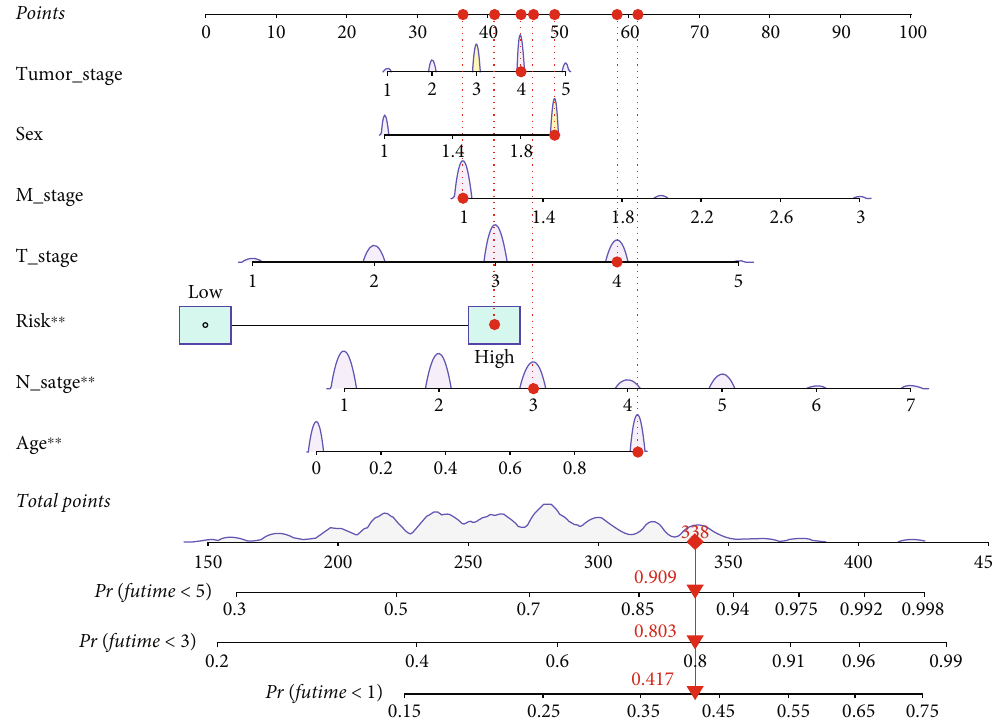
Figure 6: The nomogram of traditional clinicopathological factors and ferroptosis-related prognostic